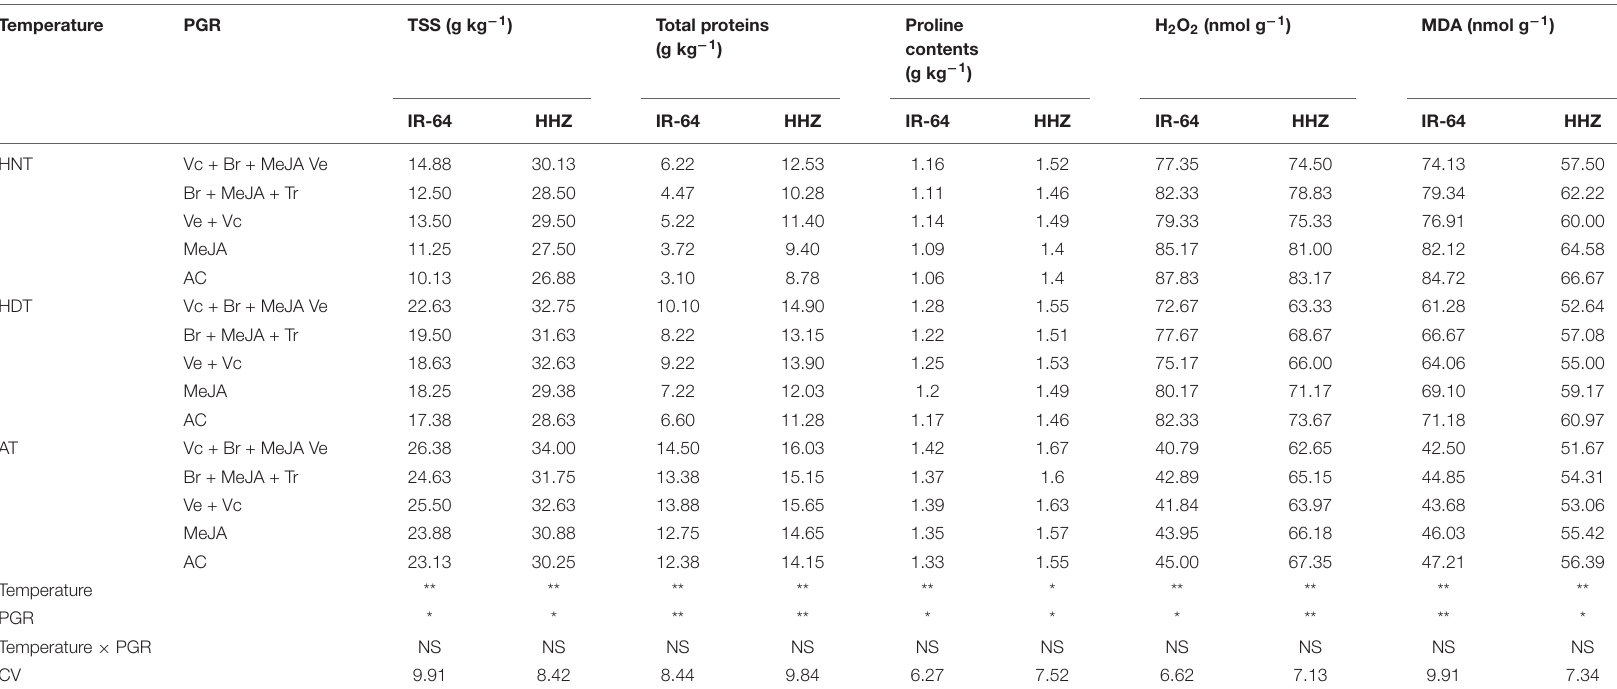
TABLE 1 | Total soluble sugars (TSS), proteins, proline, H 2 O 2 , and MDA accumulation in the leaves of two rice cultivar as affected by plant growth regulators under heat stress at heading.